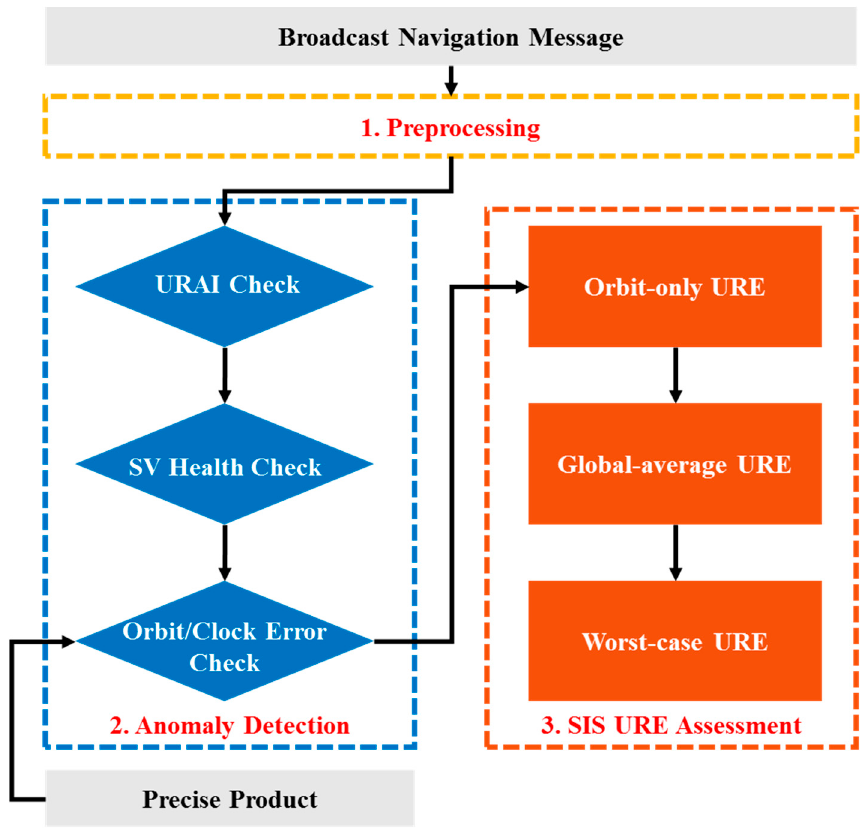
Figure 2. BDS broadcast navigation message analyzing flowchart.